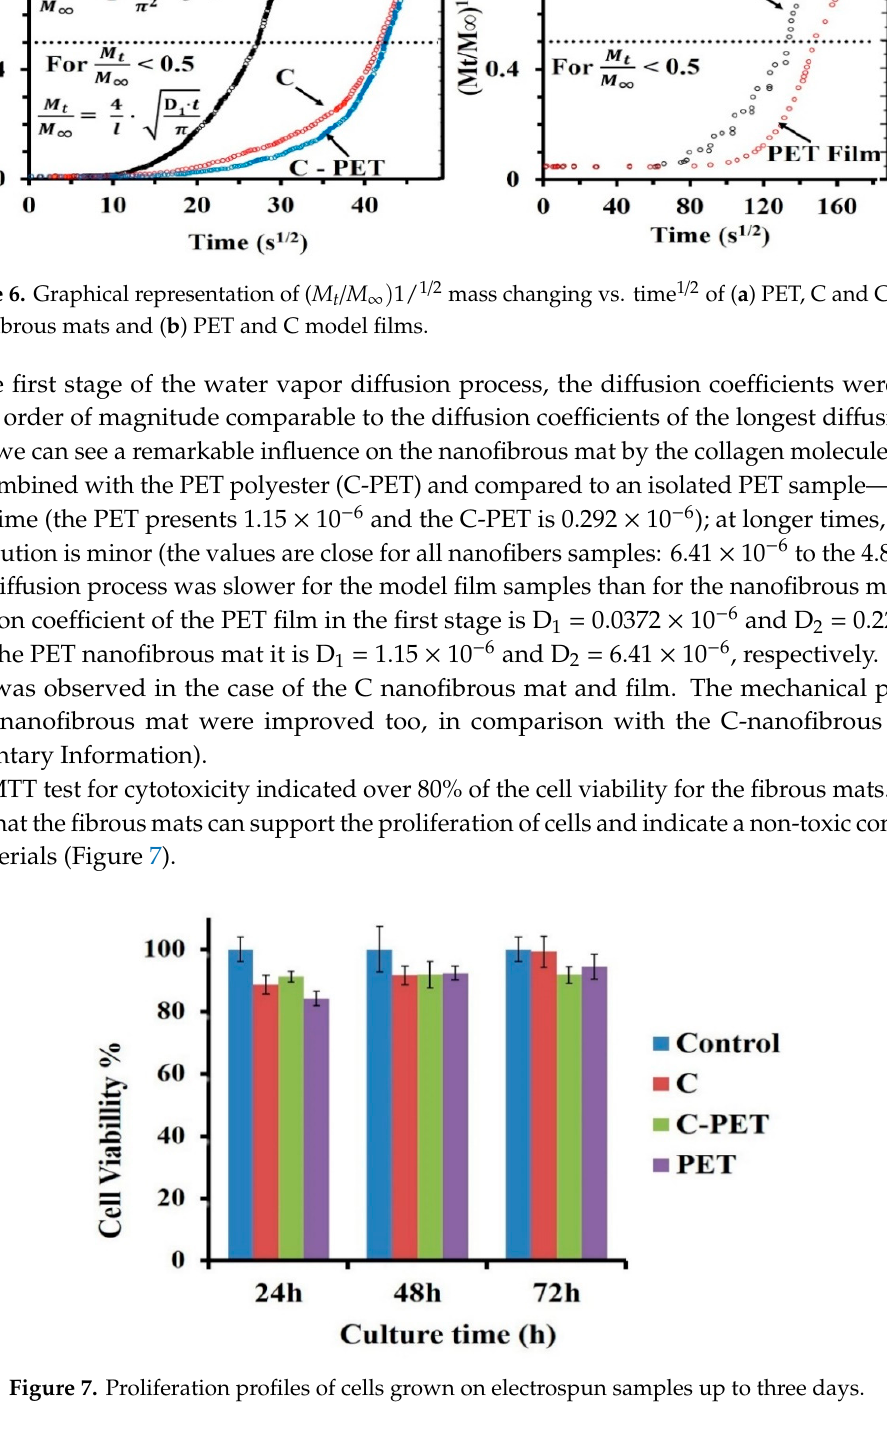
Figure 8. Cells cultured on nanofibrous mats of ( a ) C, ( b ) C-PET and ( c ) PET. ( d ) Schematic mechanism of proliferated cell growth. Cell adhesion to fibrous networks is influenced by the presence of collagen in the structure, which bridge large distances between fibers and fiber diameters. All obtained electrospun scaffolds showed a very good biocompatibility and facilitated cell attachment and proliferation. For C-PET, the fiber size and interconnection of the two polymers led to a stabilized structure, and cell growth was observed on a much denser structure than C, which had fiber dimensions up to the value of 780